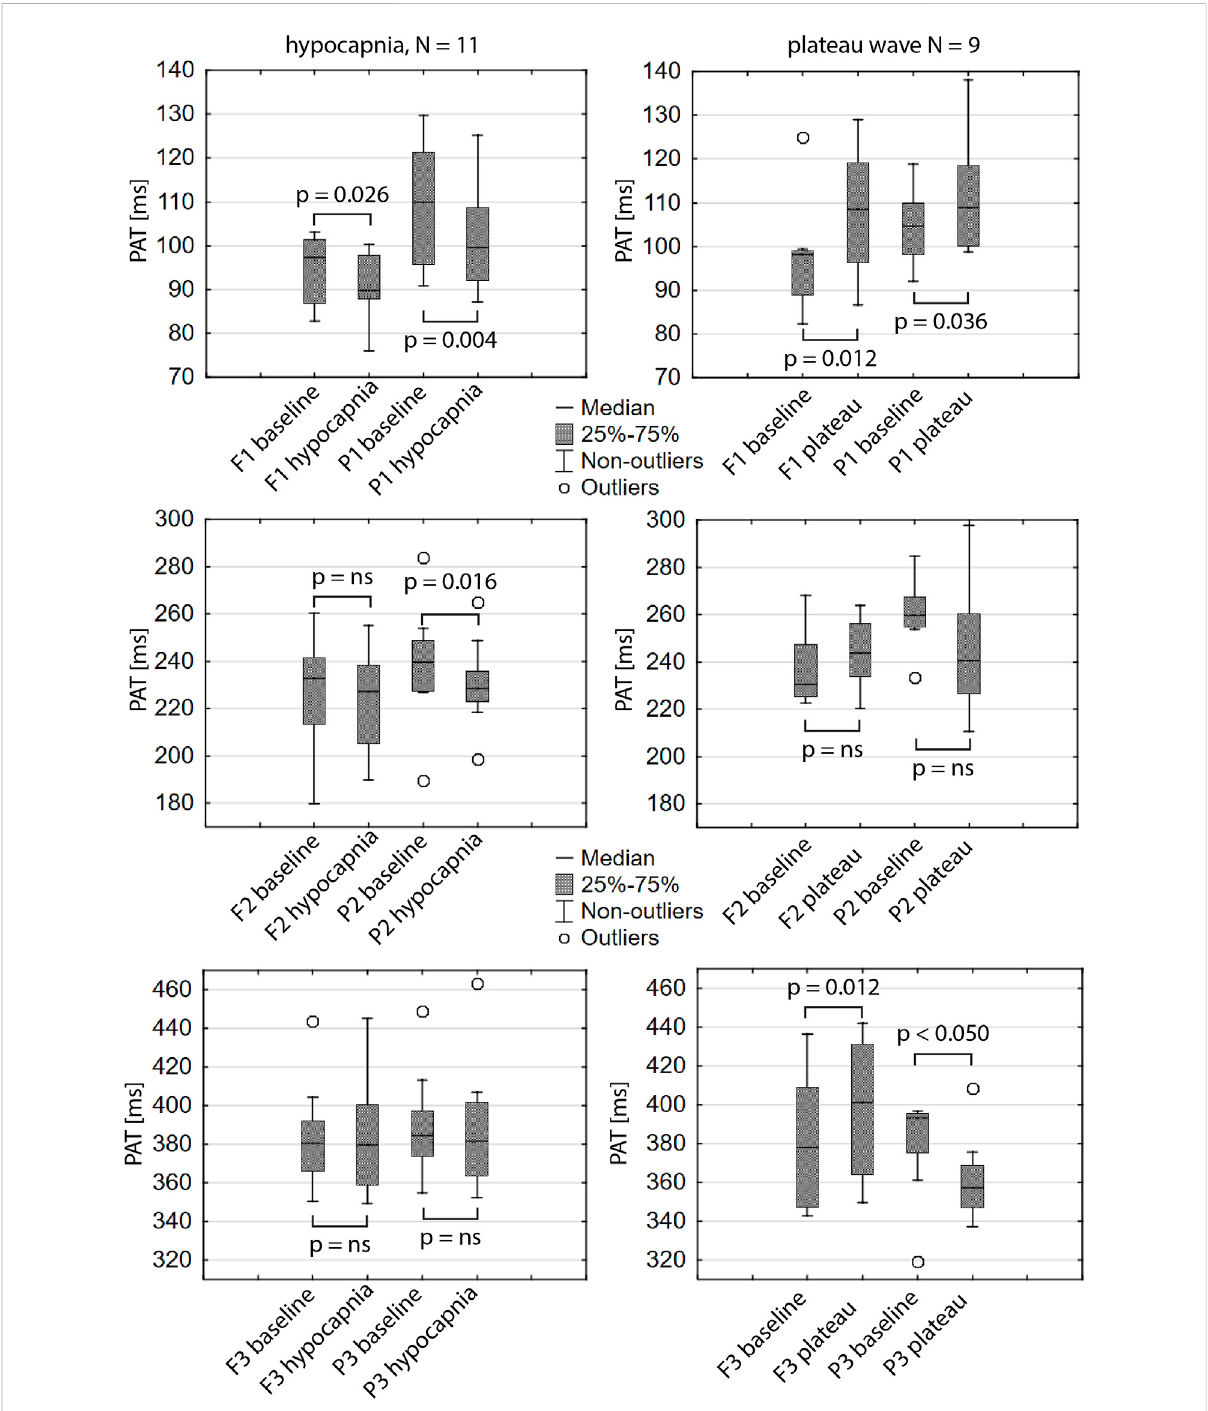
FIGURE 5 Peakappearancetimes(PATs)ofthe fi rst,secondandthirdpeaksofintracranialpressure(P1,P2,P3)andcerebralarterialblood fl owvelocity(F1, F2, F3). Box-plots in the left column present PATs during hypocapnia and preceding baseline. Right column shows PATs during ICP plateau waves and corresponding baselines. N – number of patients in the group, p – p -value of Wilcoxon signed rank test, ns – p -values greater than